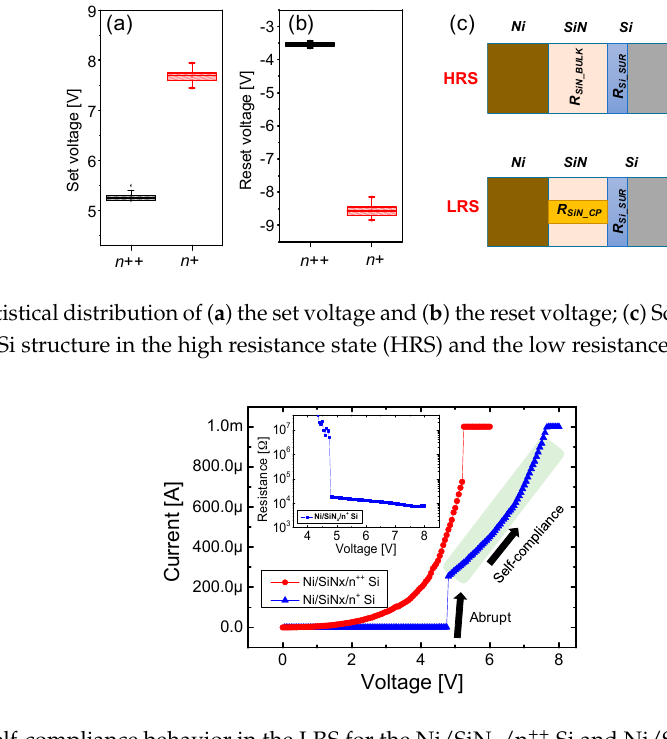
Figure 4. Statistical distribution of ( a ) the set voltage and ( b ) the reset voltage; ( c ) Schematics illustrating the Ni/SiN/Si structure in the high resistance state (HRS) and the low resistance state (LRS).